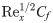
Time-series of the skin friction coefficient Rex1/2Cf in the first five periods τ ∈ [8π, 10π]: (a) effects of β with K = 0.2, S = 1 and γ = 0.5 and (b) effects of γ with K = 0.2, S = 1 and β = 12.